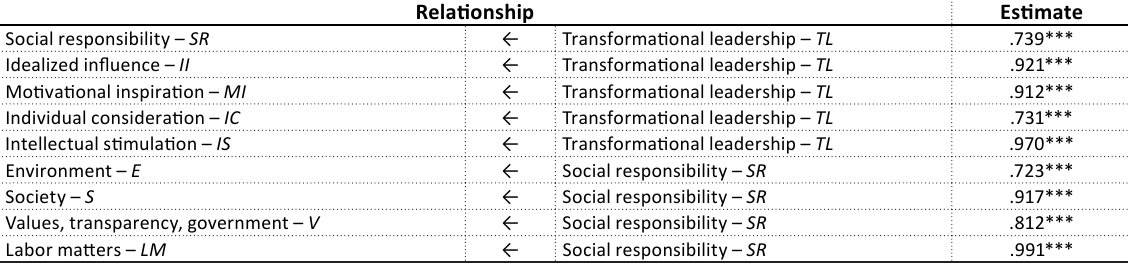
Figure 1. Results of the structural equation model Table 4. Correlations between the variables and their